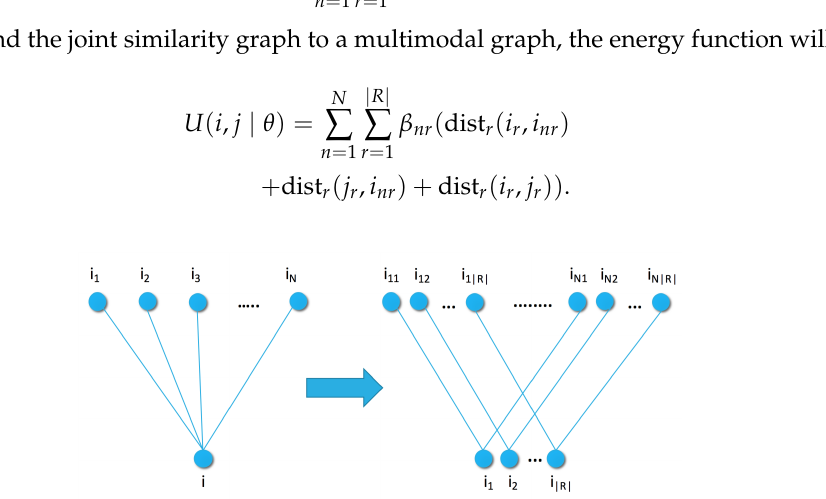
Figure 3. Single and multimodal similarity graph with sample set S = { i 1 , i 2 ,..., i N } and | R |